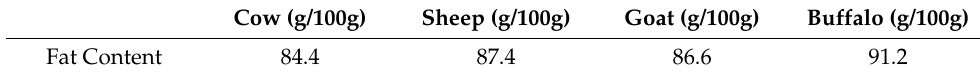
Table 5. Fat content (g/100g) in cream samples from cow, buffalo, goat and sheep cream samples. Cow (g/100g) Sheep (g/100g) Goat (g/100g) Buffalo (g/100g) Fat Content 84.4 87.4 86.6